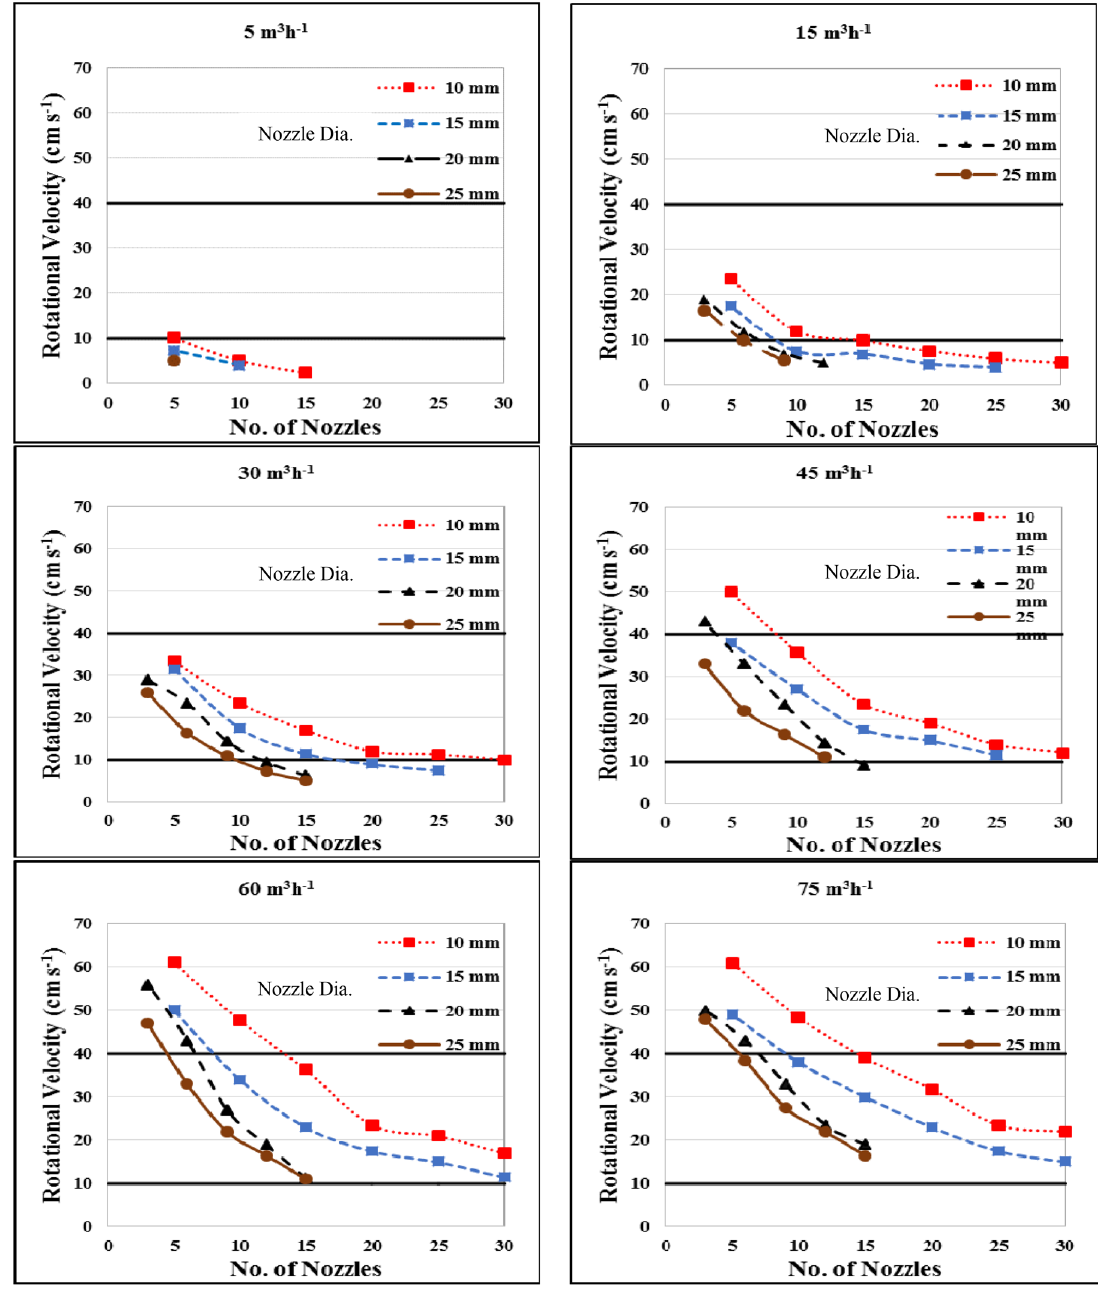
Figure 3. Effect of flow rate, nozzle diameter and number of nozzles on the rotational velocity of water in a circular